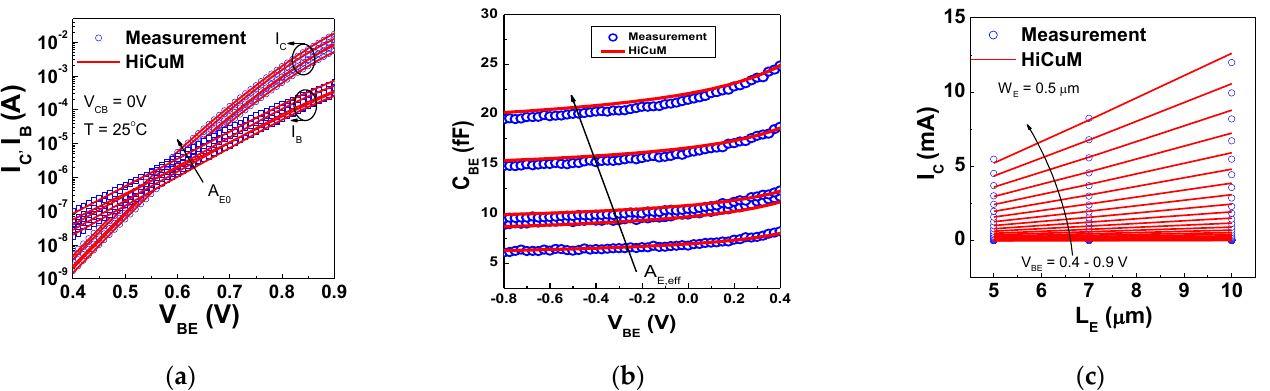
Figure 4. ( a ) Gummel plots at V BC = 0 V; ( b ) the B–E junction capacitances; and ( c ) the collector current scaling.